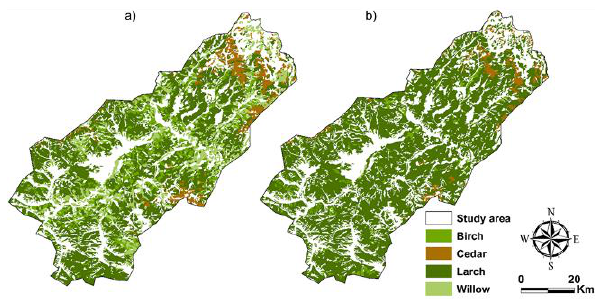
Figure 6. Forest tree species classification map for the study area using a) Landsat 8 surface reflectance and b) topographic variables coupled with Landsat 8 surface reflectance. The area